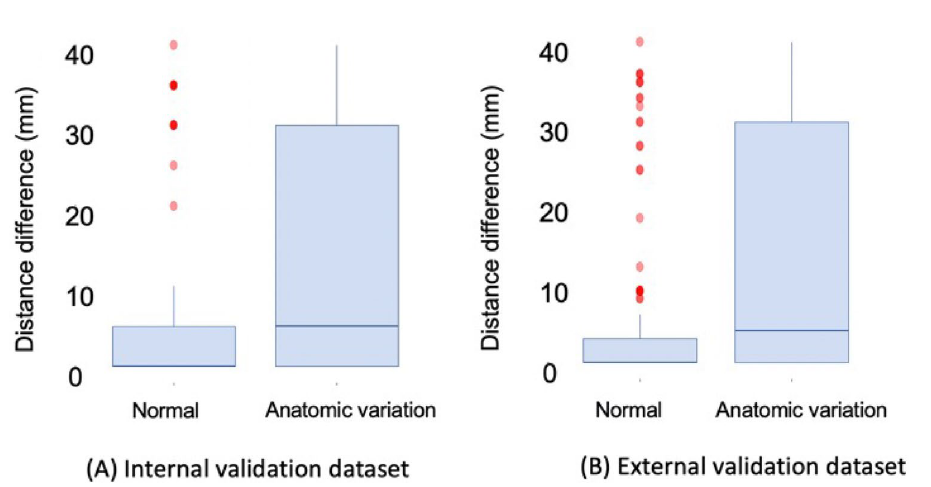
Figure 5. Box plots of distance difference between ground truth and deep learning model (DLM) derived results in (A) internal validation dataset and (B) external validation cohorts. The mean differences between the ground truth and the DLM-derived results were 3.7 mm ± 8.4 and 4.1 mm ± 8.3 for the internal, and external validation cohorts,